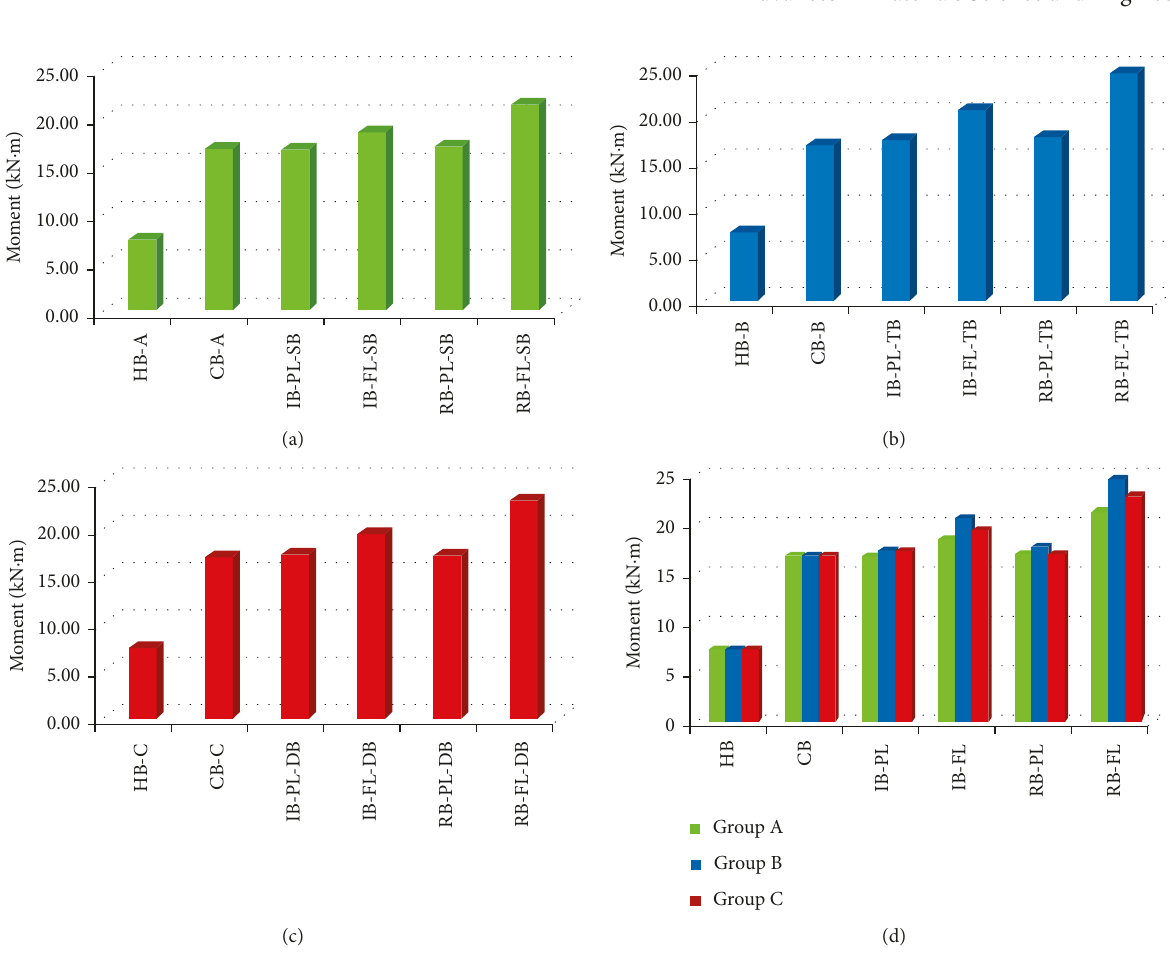
Figure 13: Ultimate moment capacity. (a) Group A beams. (b) Group B beams. (c) Group C beams. (d)